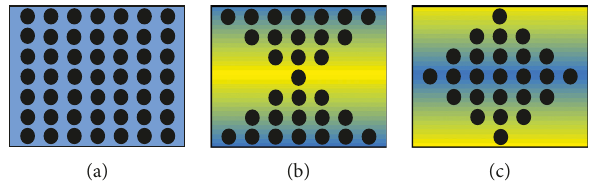
Figure 2: Different CNT distribution types in the CNTRC com- posite structure: (a) UD, (b) FG-X, and (c)